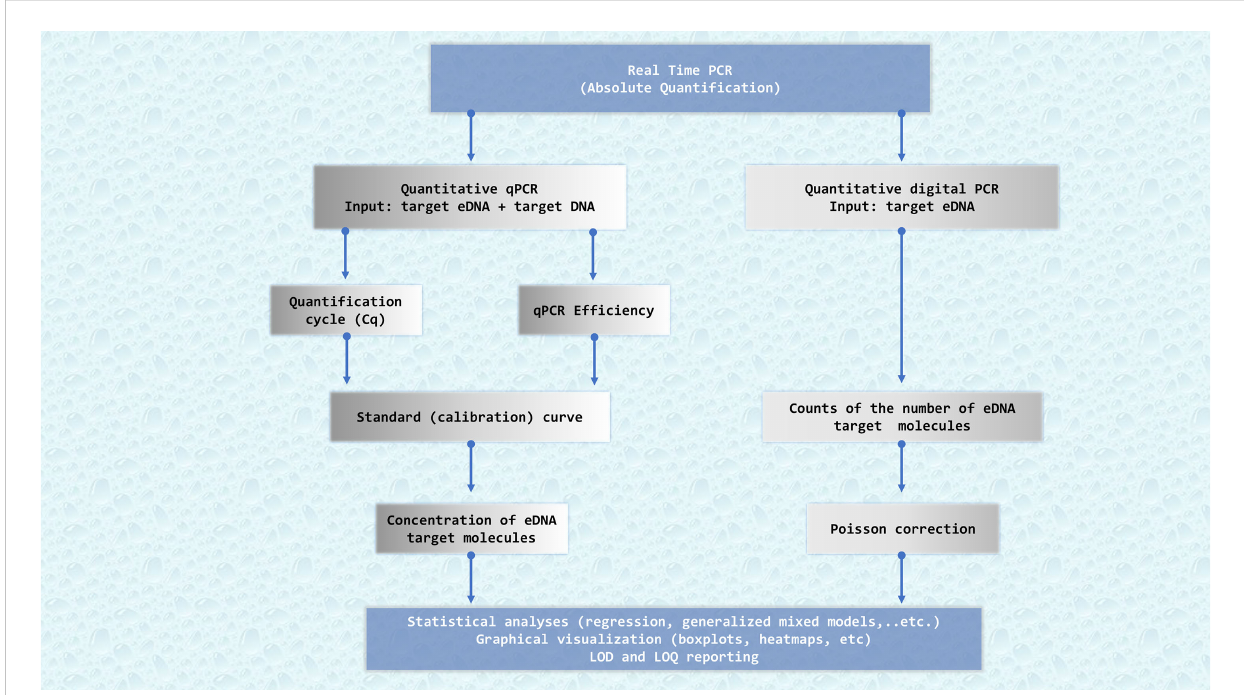
FIGURE 2 Flowchart describing the key bioinformatics steps required to get successful results quantifying eDNA from marine samples. qPCR: real-time quantitative PCR, dPCR: digital PCR. Quanti fi cation of eDNA samples by qPCR needs a standard calibration curve, whereas digital PCR directly counts eDNA target molecules splitting the PCR reaction in tiny volumes. Cq: quanti fi cation cycle, a PCR cycle at which the accumulating PCR products ’ fl uorescence reaches a pre-established threshold. Ef fi ciency, which measures the overall performance of the qPCR. A standard curve is obtained by plotting Cq values versus DNA concentration for different dilutions of a target DNA sample of known concentration. LOD, Limit of Detection. LOQ, Limit of Quanti fi